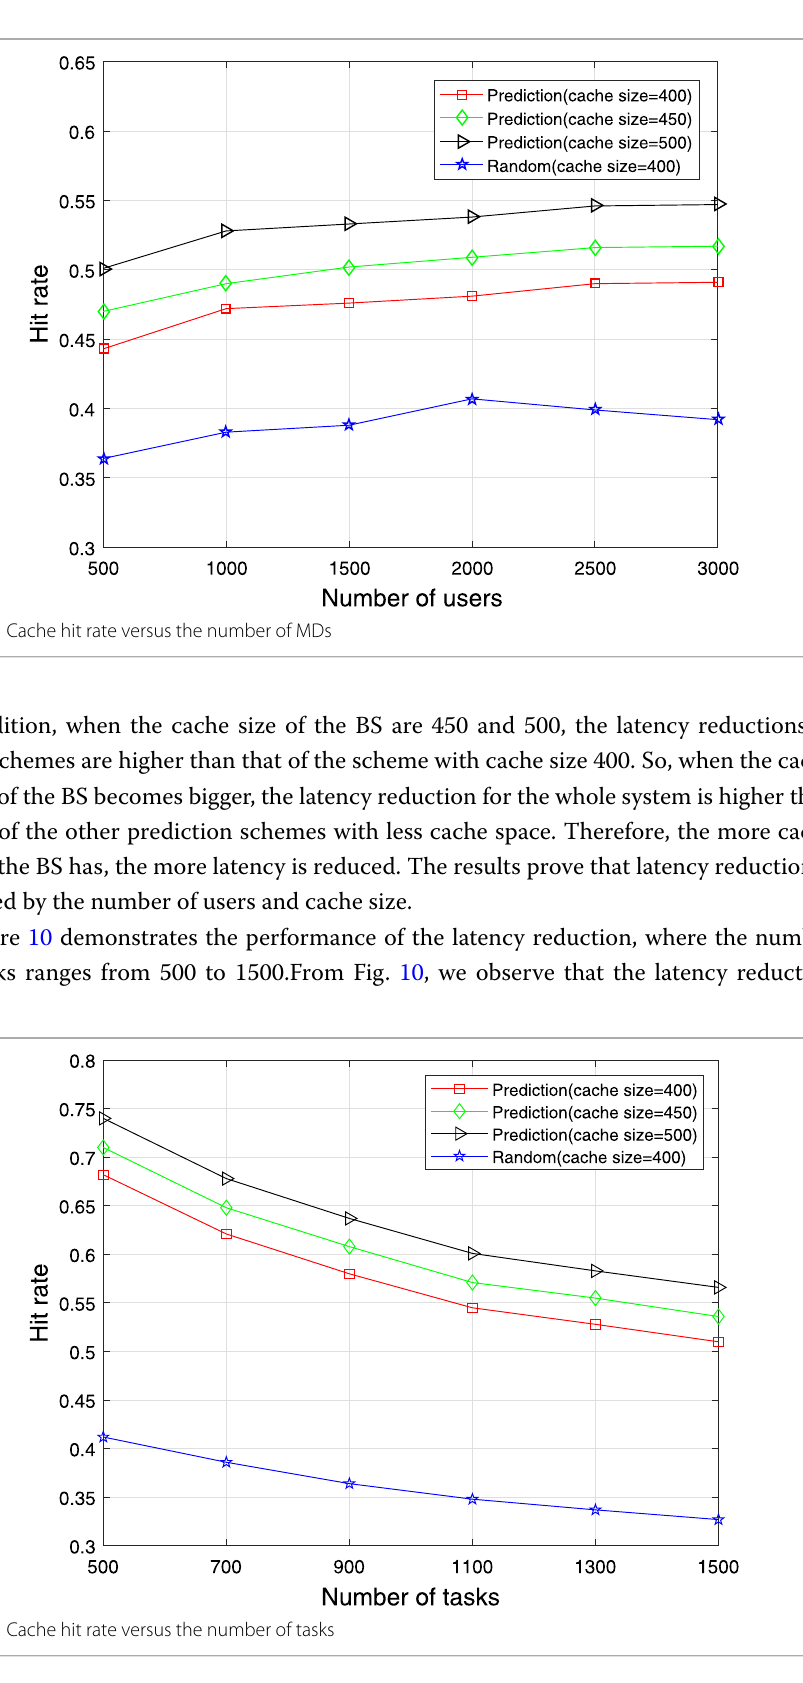
Fig. 7 Cache hit rate versus the number of